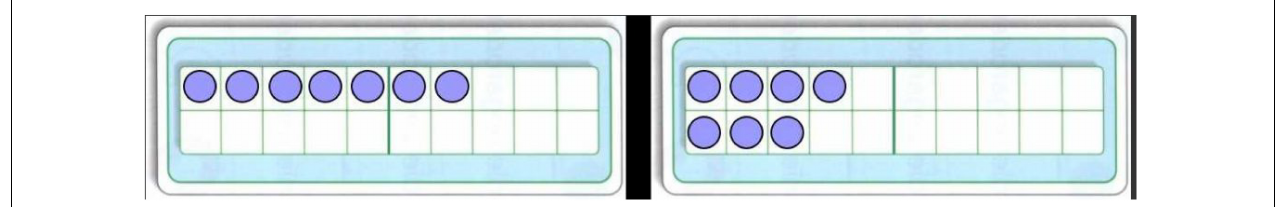
FIGURE 2 | On the left hand side the blocks for decomposing 7 are based on the “strength of five ,” while the decomposition on the right hand side goes down to a block of 4 dots and the rest, namely 3 dots or 6 dots like the cube and one.